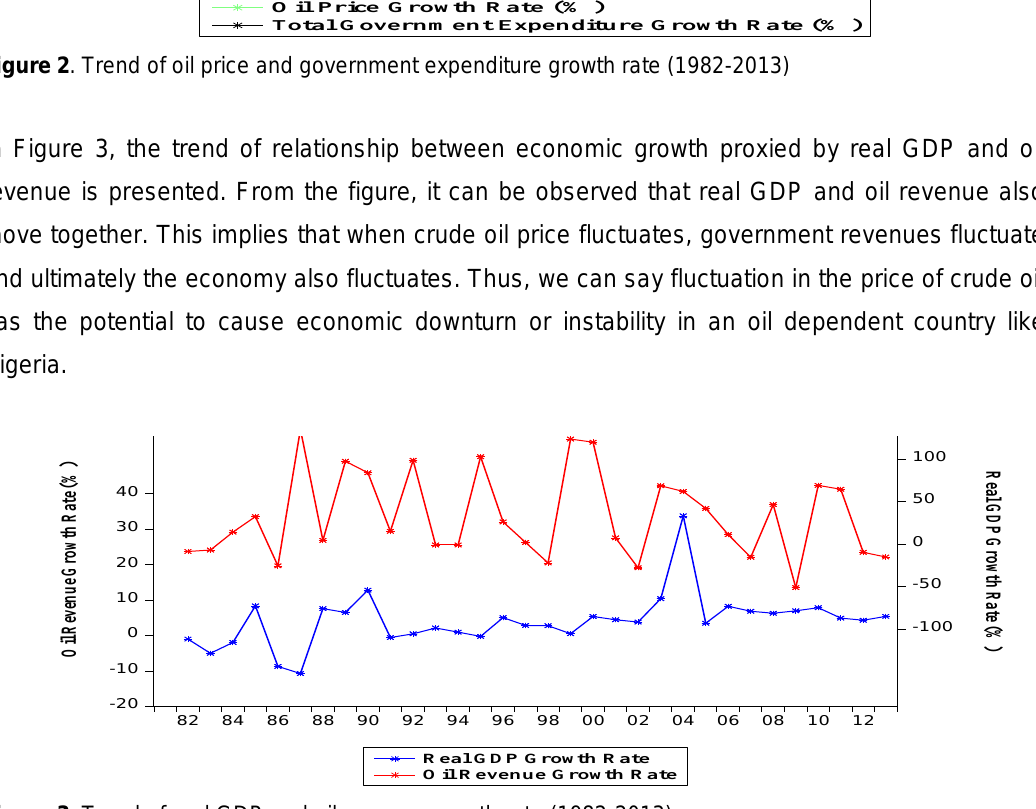
Figure 3 . Trend of real GDP and oil revenue growth rate